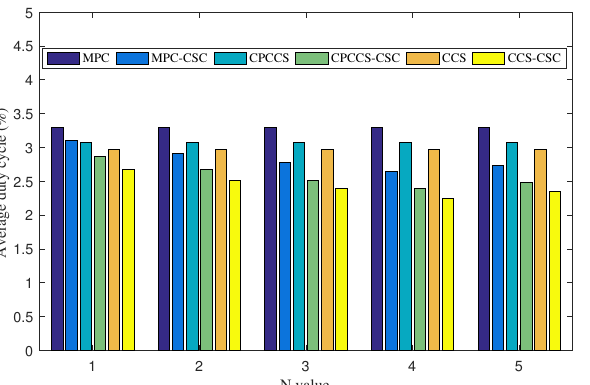
Figure 4. Average duty cycle of nodes running MPC, MPC-CSC, CPCCS, CPCCS-CSC, CCS, and CCS-CSC under various neighborhood sizes, N